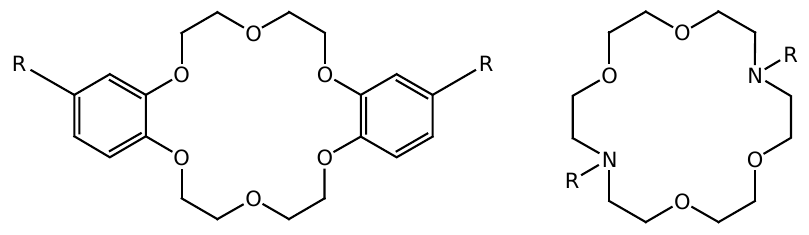
Figure 9. The arms can be added to either the carbon or the nitrogen atoms of the crown.